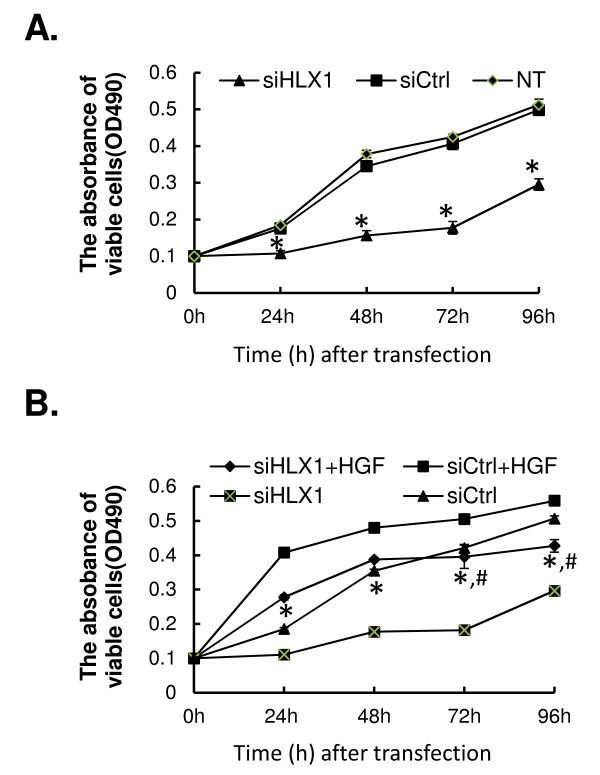
Targeted silencing of HLX1 inhibits basal and HGF-induced cell growth. (A) HTR-8/SVneo cells were either not transfected (NT), or transfected with siCtrl or siHLX and cell growth at 0, 24, 48, 72 and 94 h after transfection was determined by MTT assay. (B) HTR-8/SVneo cells were transfected with either siCtrl or siHLX1 at time 0, and treated with or without 20 ng/mL HGF. Cell growth at 0, 24, 48, 72 and 94 h after transfection was determined by MTT assay with the absorbance of viable cells read at 490 nm (OD490). All quantitative data are presented as mean ± SD for three independent experiments. *P < 0.01, as compared to NT cells or siCtrl-transfected cells (in A), and to siCtrl + HGF or siHLX1 cells (in B). #P < 0.01, as compared to siHLX1 + HGF cells (in B).